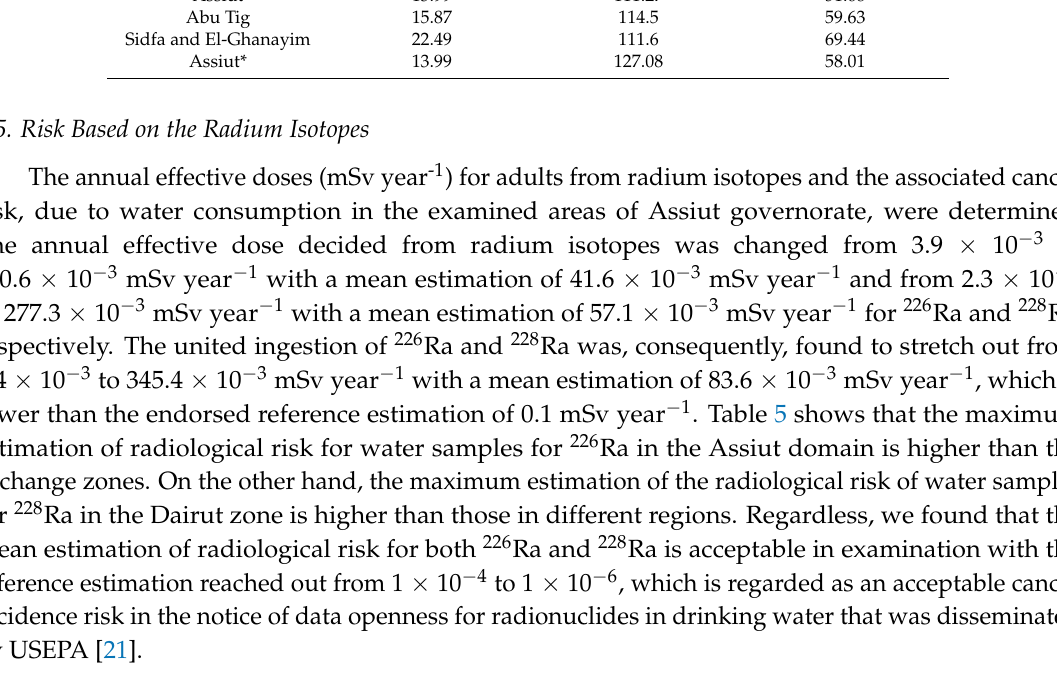
Table 5. The ranges and average values of annual effective doses (mSv year − 1 ) for adults and the radiological risk of radium isotopes for water